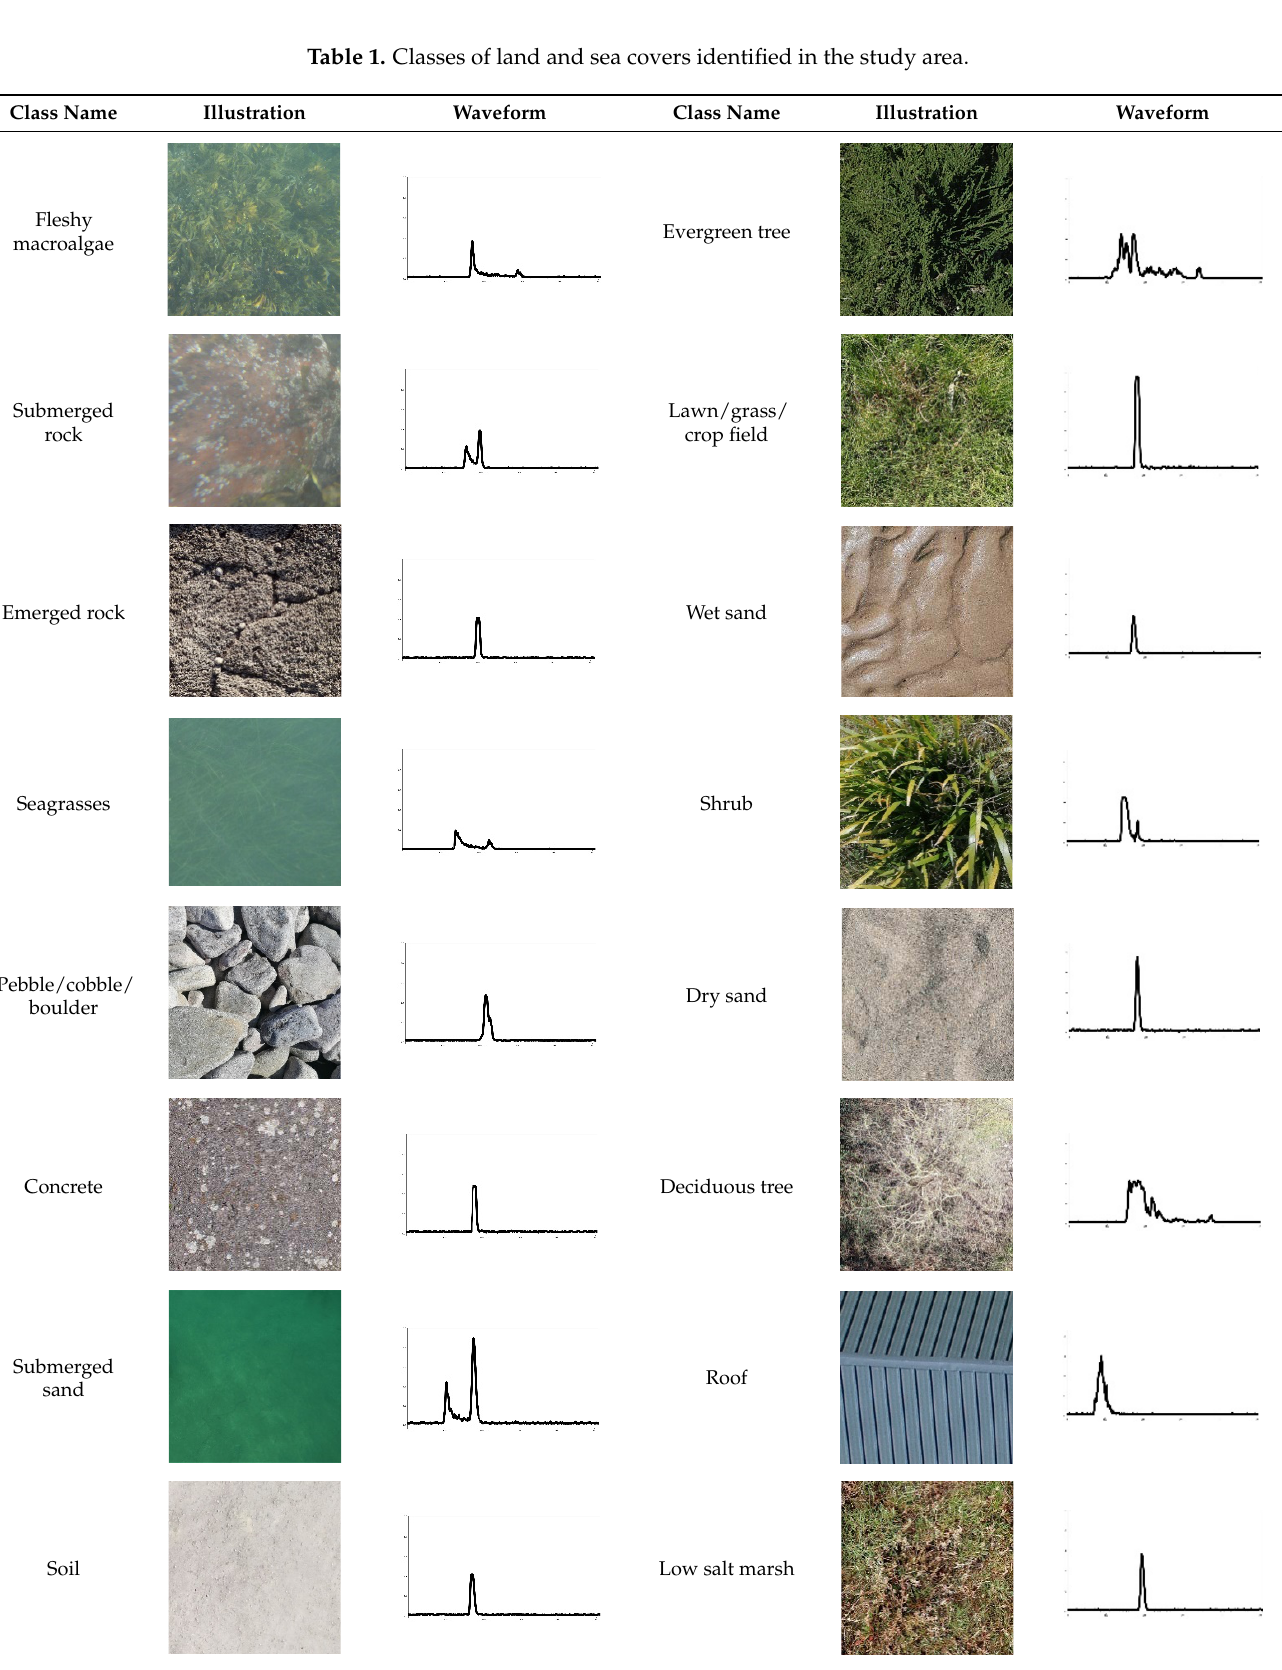
Table 1. Classes of land and sea covers identified in the study area.